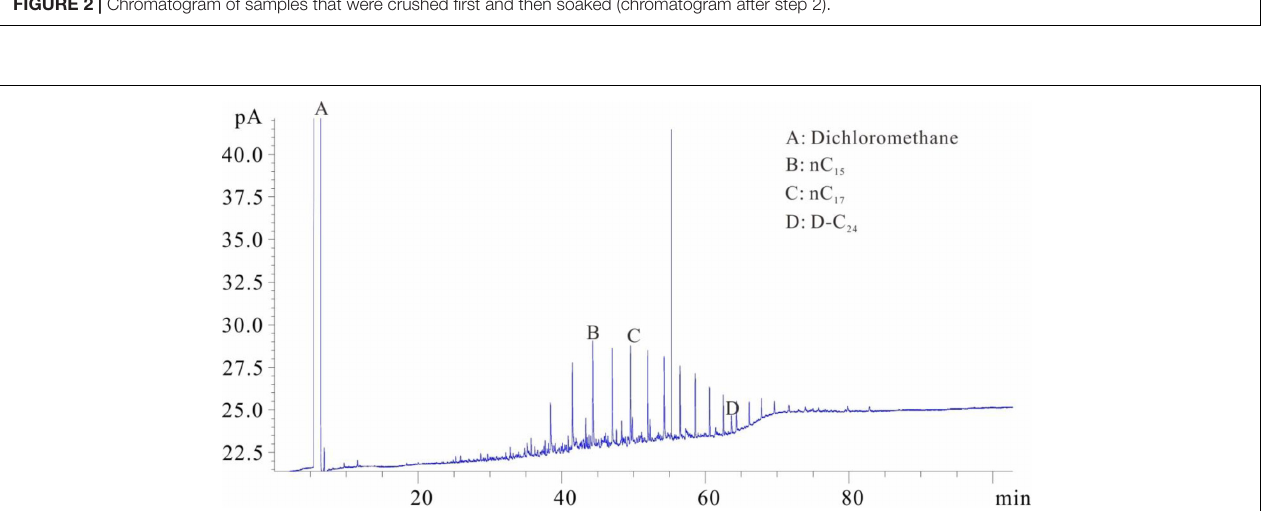
FIGURE 2 | Chromatogram of samples that were crushed first and then soaked (chromatogram after step 2).